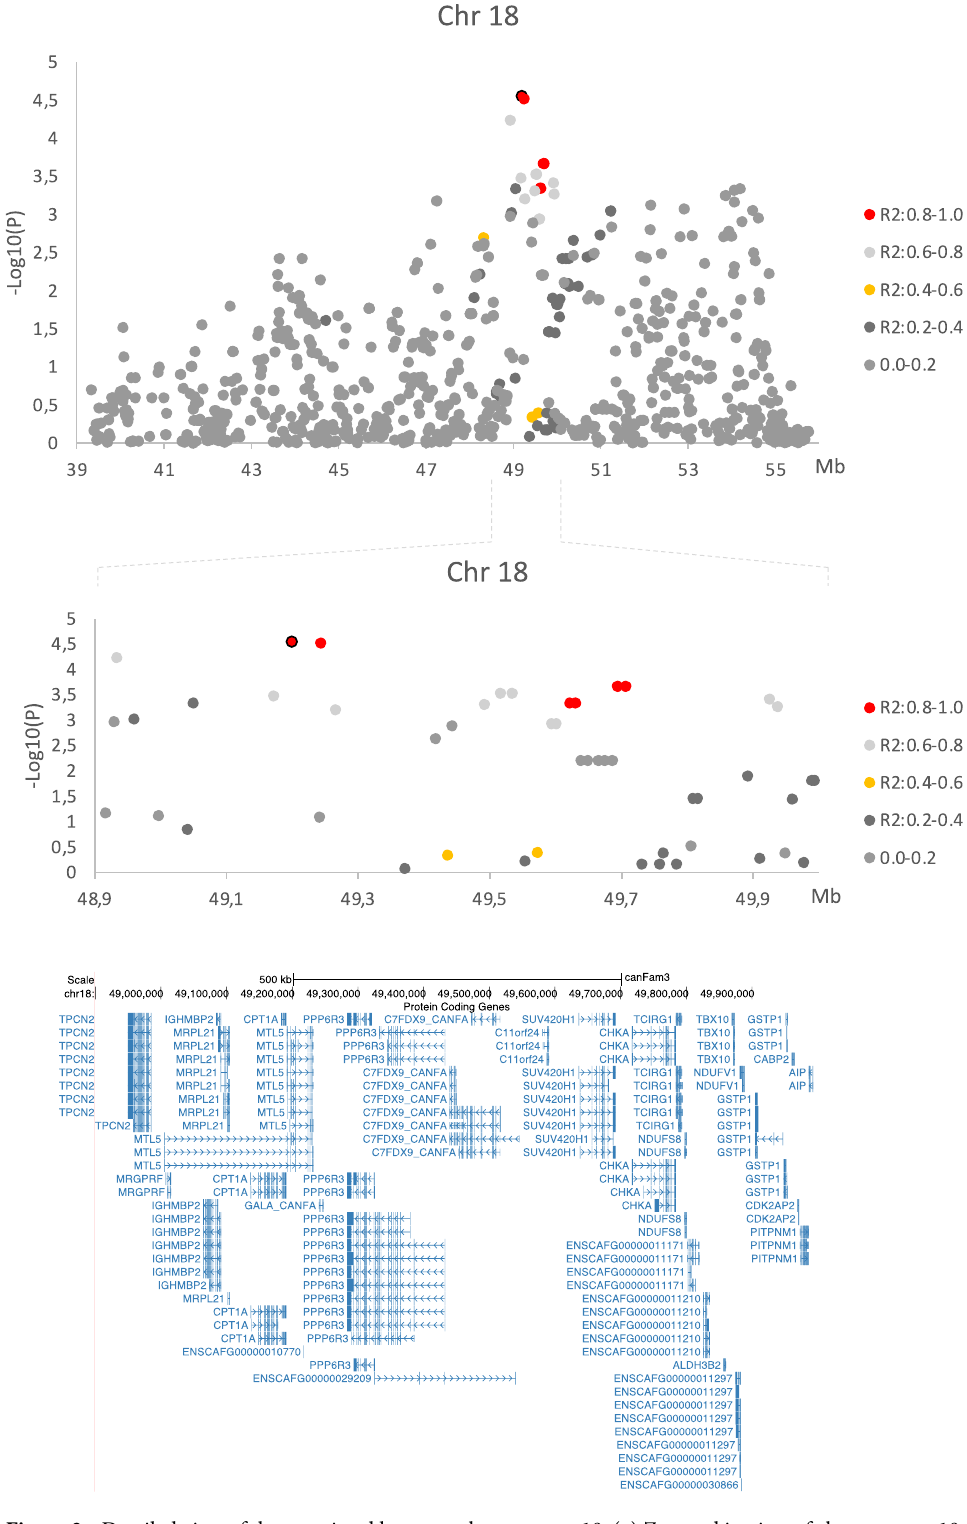
Figure 2. Detailed view of the associated locus on chromosome 18. ( a ) Zoomed in view of chromosome 18. The LD R 2 -value between the most highly associated SNP is illustrated by colour. ( b ) Further zoomed in view showing chr18 48.9–50 Mbp. ( c ) annotation of the region chr18 48.9–50 Mbp based on the UCSC browser